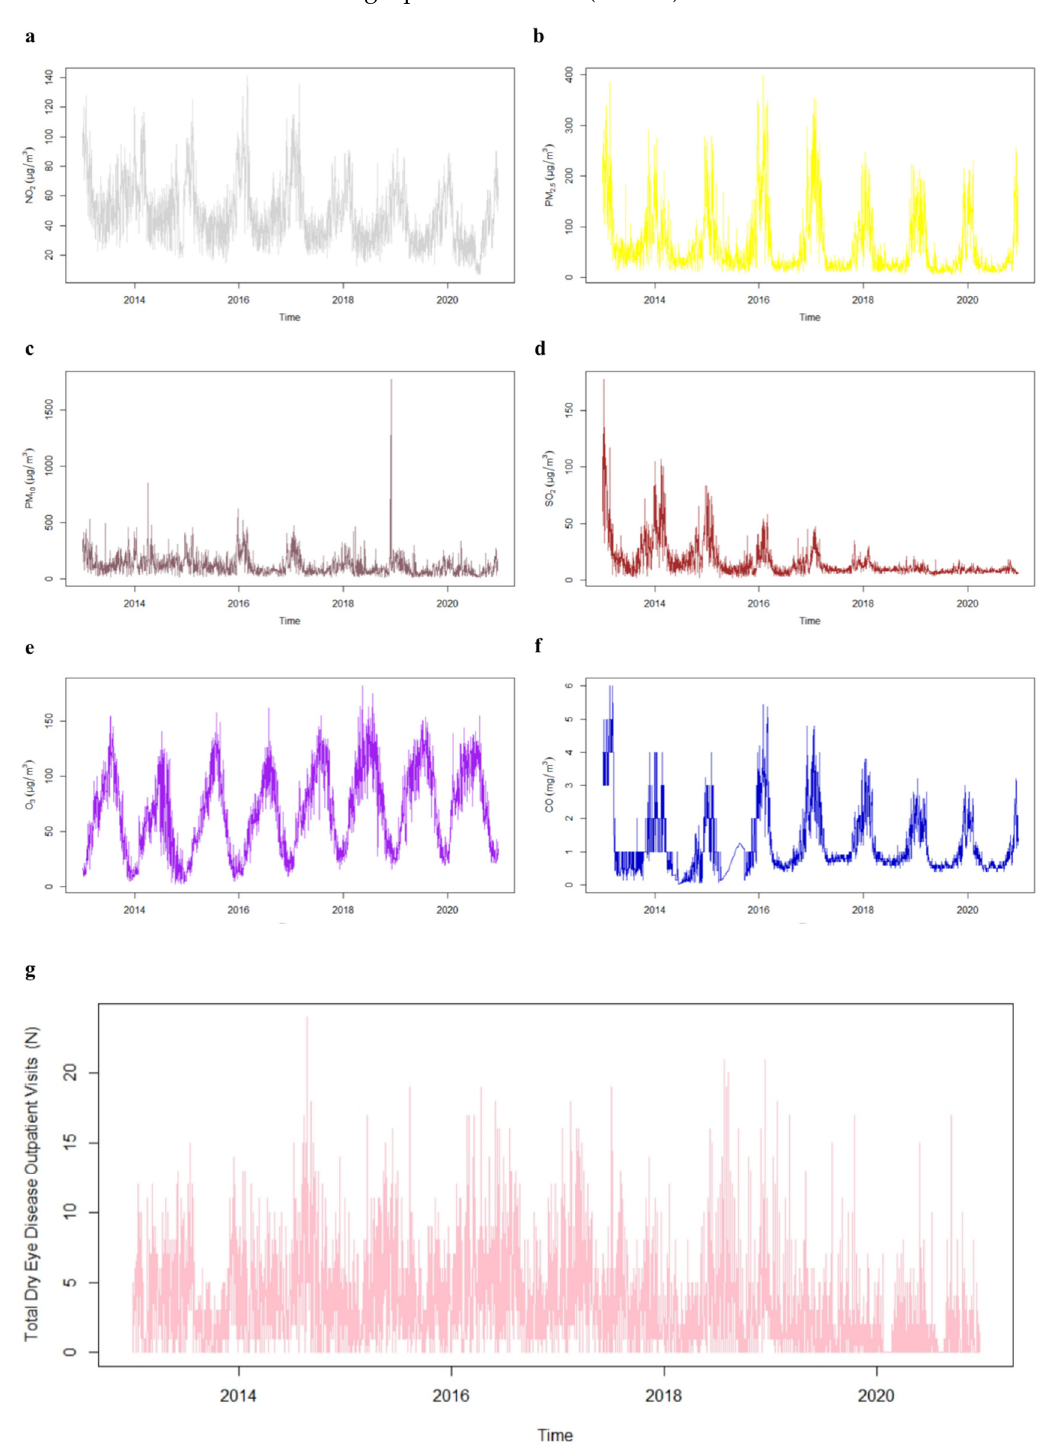
Figure 2. Distribution of exposure to NO 2 ( a ), PM 2.5 ( b ), PM 10 ( c ), SO 2 ( d ), O 3 ( e ), CO ( f ), and outpatient visits for dry eye disease (DED) ( g ) over time in Urumqi, Xinjiang, 1 January 2013 to 31 December 2020. Different colors represent different types of air pollutants/number of DED outpatient visits, gray (NO 2 ), bright yellow (PM 2.5 ), brown (PM 10 ), rufous (SO 2 ), purple (O 3 ), blue (CO) and red (DED outpatient visits).